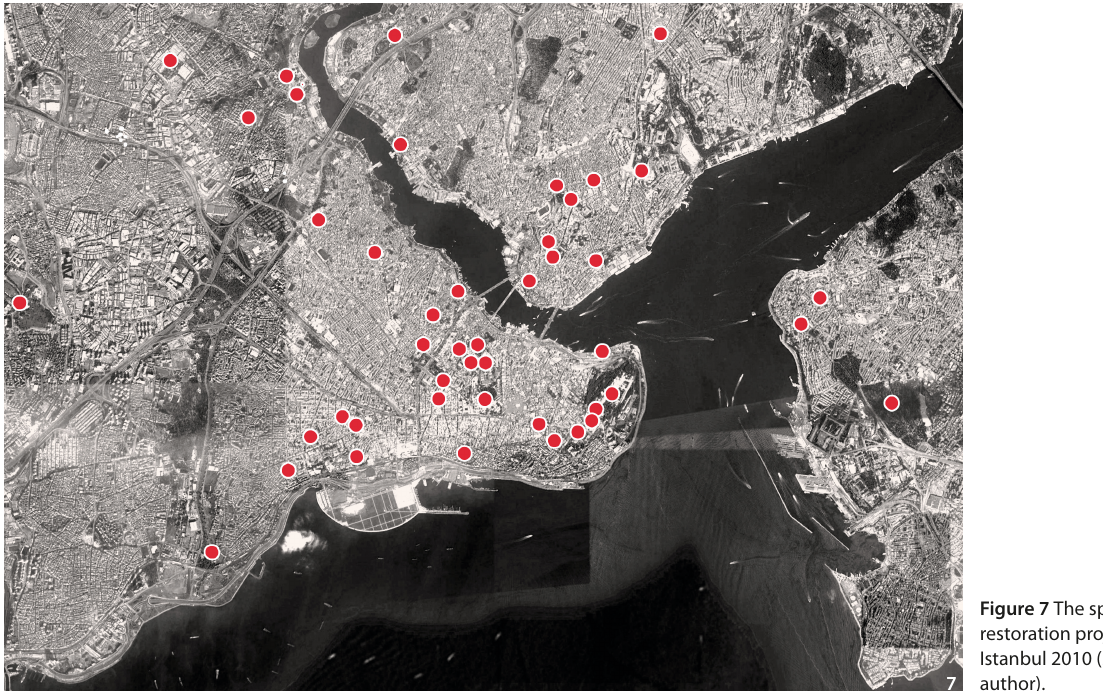
Figure 7 The spread of restoration projects for Istanbul 2010 (Source: the